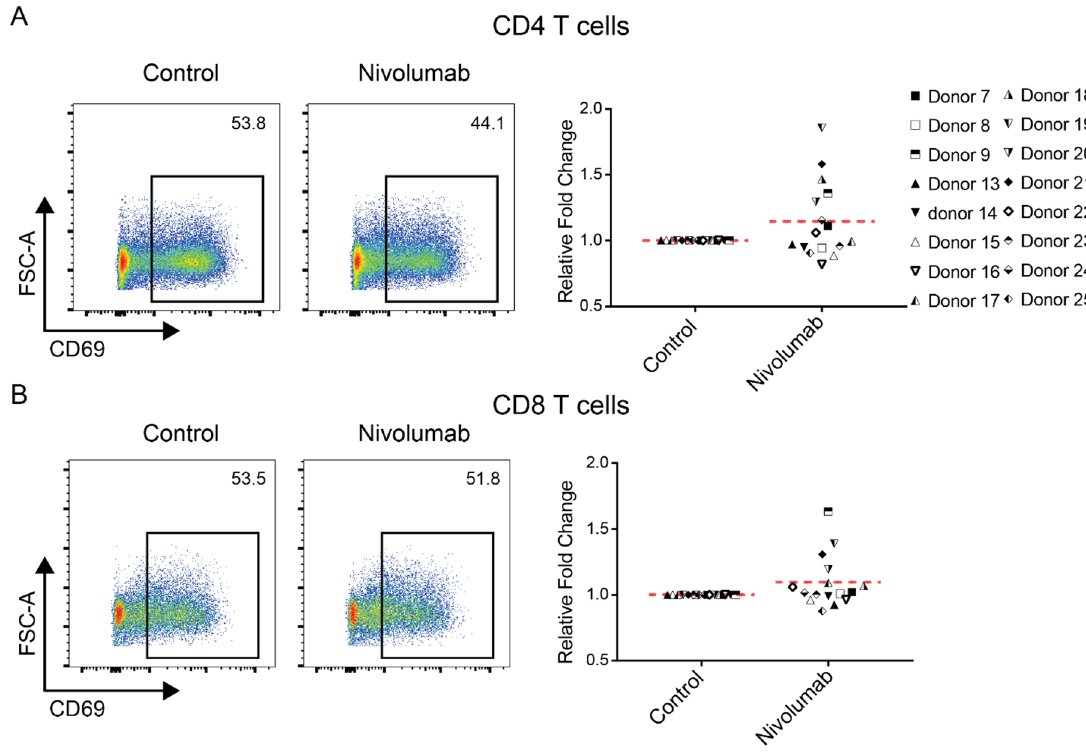
Figure 4. Nivolumab treatment does not impact T cell activation. Frozen PBMCs were thawed and cultured in RPMI1640 medium containing 5% AB human serum. Cells were then treated with Nivolumab (20 µ g / mL) in the presence of anti-CD3 mAb (0.1 µ g / mL) for three days and were then harvested for flow cytometric analysis of the expression of T cell activation marker CD69. Shown is the expression of CD69 in CD4 + T cells ( A ) and CD8 + T cells ( B ). The left panels show the data from one representative donor, whereas the right panel provides a summary of data from 16 different individual donors.